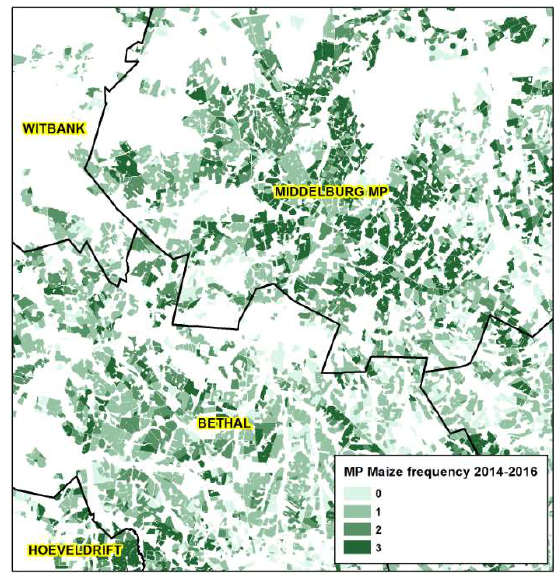
Figure 20. The frequency occurrence of maize per field between 2014 and 2016 in an area of Mpumalanga